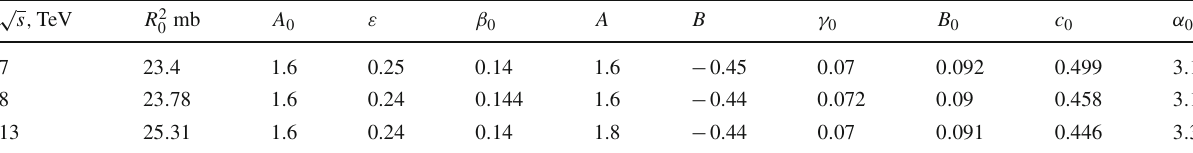
(cid:14) (cid:15) / r 2 , two-quark force 0 p ( s ) = σ ( s )/π and the experimental in 0